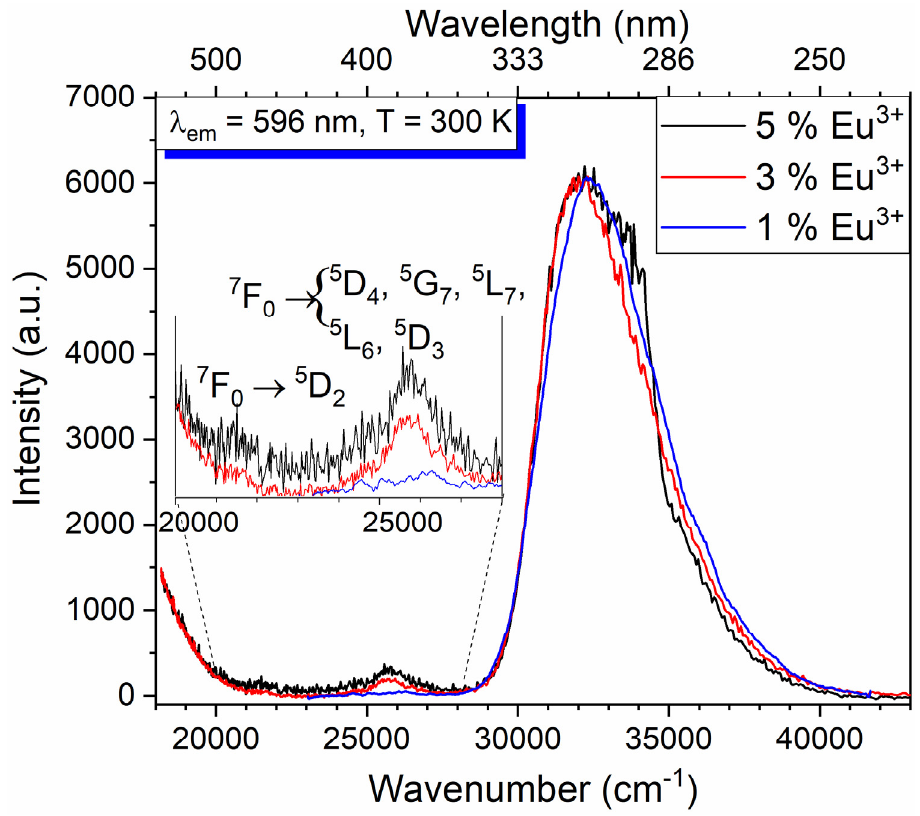
Figure 6. The 300 K excitation spectra of Ba 2 MgWO 6 : 5% Eu 3 + (black), 3% Eu 3 + (red) and 1% Eu 3 +